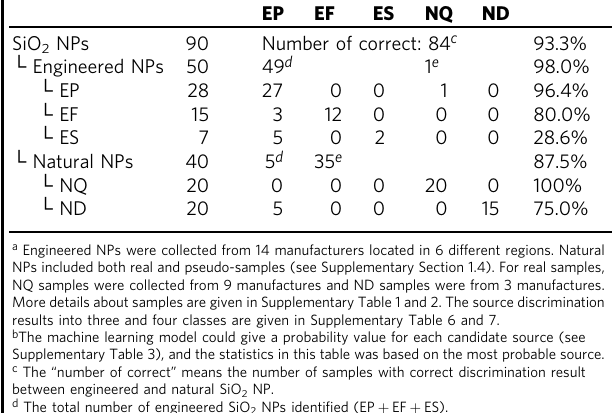
Table 1 Source discrimination results of SiO 2 NPs of known sources into fi ve classes by the machine learning model a